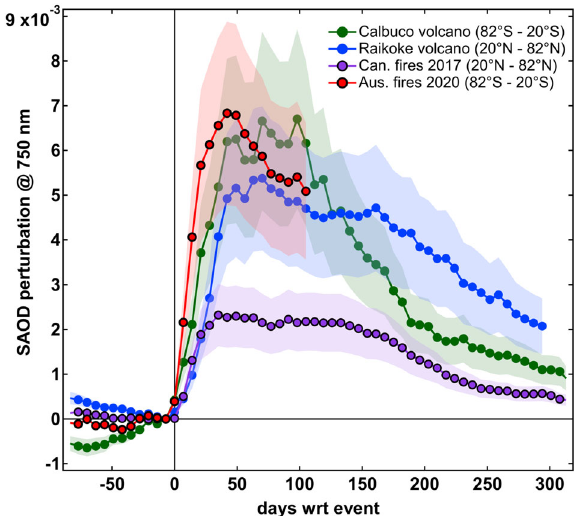
Fig. 3 Perturbation of the stratospheric aerosol optical depth (SAOD) due to Australian fi res and the strongest events since 1991. The curves represent the SAOD perturbation at 746nm following the Australian wild fi res, the previous record-breaking Canadian wild fi res in 2017 and the strongest volcanic eruptions in the last 29 years (eruptions of Calbuco volcano in 2015 and Raikoke volcano in 2019 [ref. 41 ]). The time series are computed from OMPS-LP aerosol extinction pro fi les as weekly-mean departures of aerosol optical depth above 380K isentropic level (see Fig. 2) from the levels on the week preceding the event. The weekly averages are computed over equivalent-area latitude bands (as indicated in the panel) roughly corresponding to the meridional extent of stratospheric aerosol perturbation for each event. The shading indicates a 30% uncertainty in the calculated SAOD, as estimated from SAGE III coincident comparisons (See